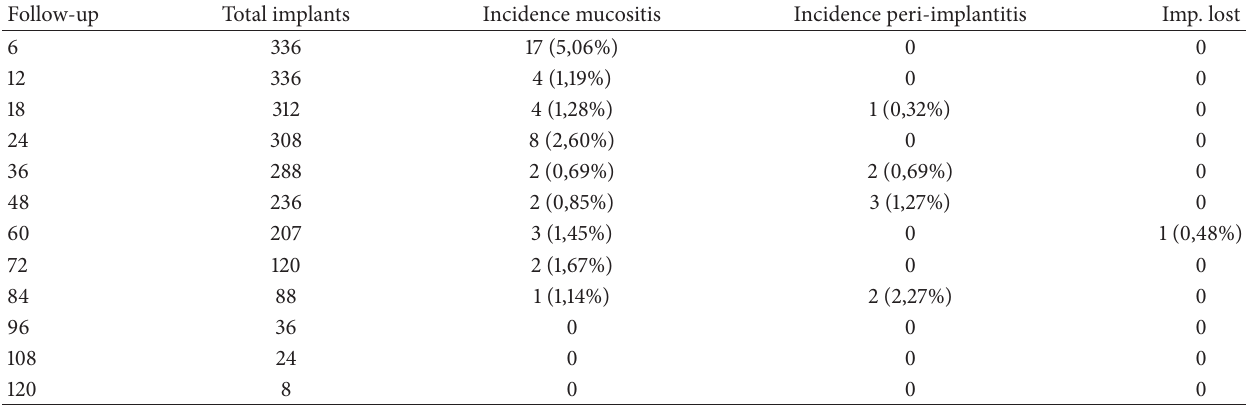
Table 5: Incidence of peri-implant mucositis and peri-implantitis.